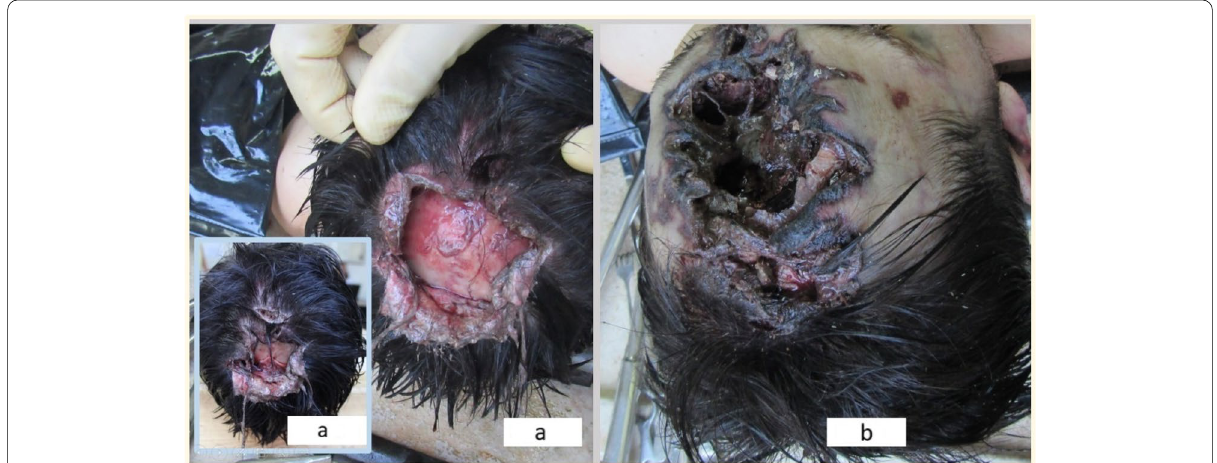
Fig. 2 The complex craniofacial trauma ‑ multiple lacerations of the scalp ( a , b ); frontal laceration with underlying fracture ( b